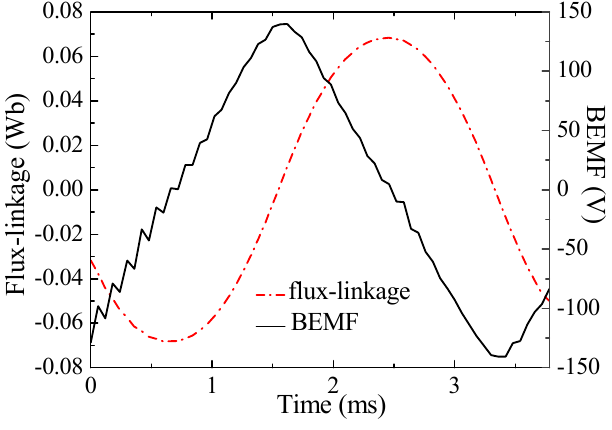
Figure 11. The flux-linkage and BEMF in one-phase at no-load.